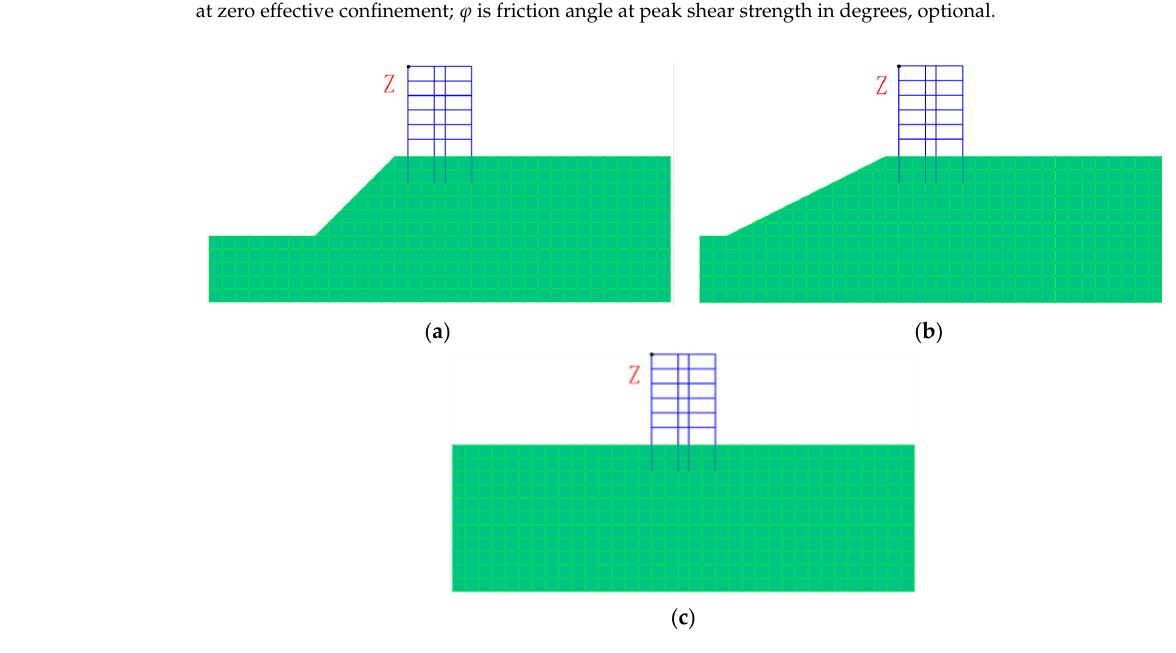
Figure 5. Finite element model. ( a ) 1:1; ( b ) 1:2; ( c ) no slope. The green part represents the soil unit, the blue part represents the upper structure, and the red font represents the observation points.